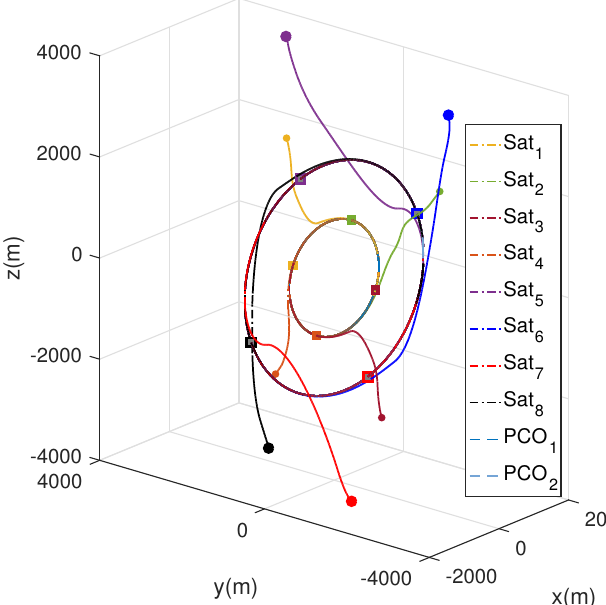
Figure 10. PB law. Plot of 3D